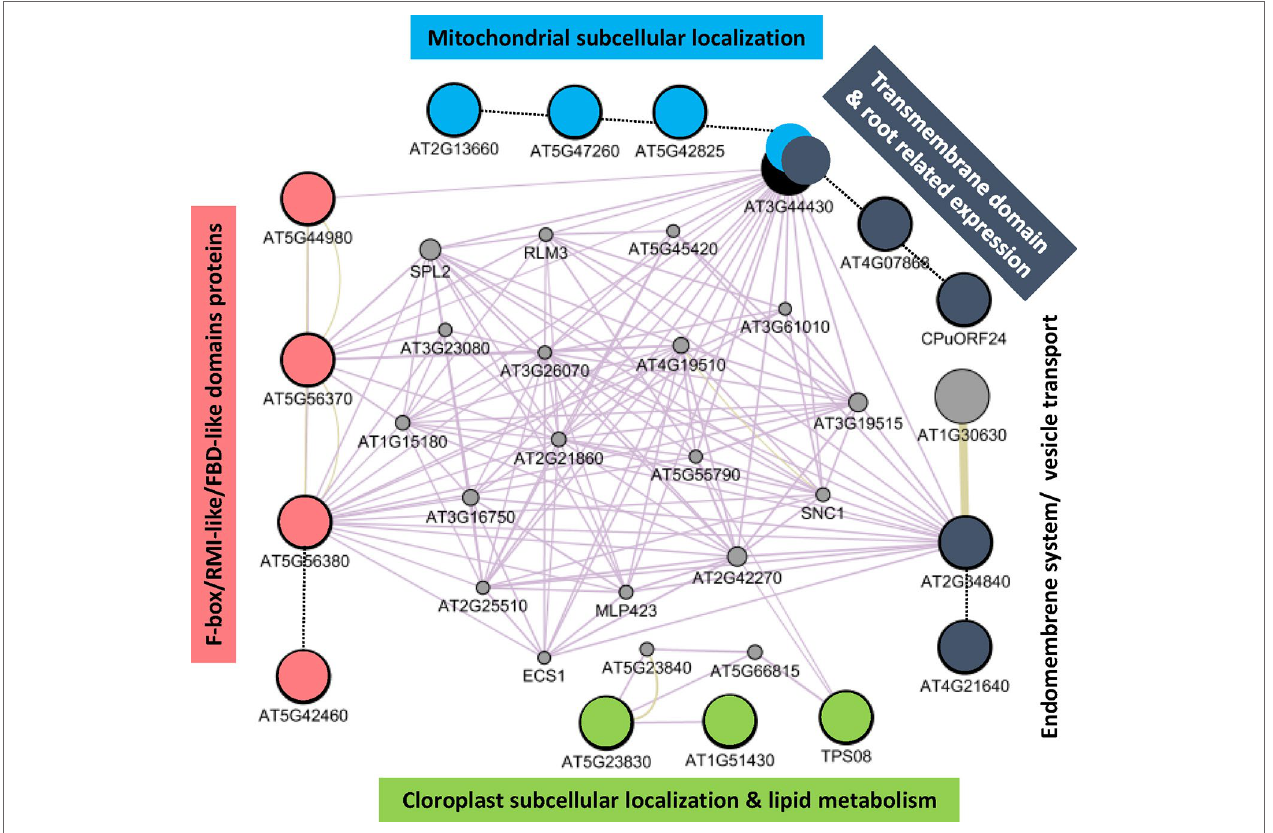
FIGURe 4 | Fifteen up-regulated genes in reduced gravity conditions can be connected in a gravity-response putative pathway. Large circles shown the genes detected in the first row clusters from the previous GEDI analysis ( Figure 3 ) and small circles are candidates to be members of a shared pathway (as detected by Genemania App in Cytoscape v3.6.1). While most of the genes have unknown function, color have been used to highlight shared features among their GO properties. Solid lines shown related features as detected by Genemania app, dotted lines have been added by manual datamining comparisons. Note that four genes expressing F-box/RMI-like proteins (in red) out of 156 genes (related examples are auxin polar transport genes as TIR-1, cell wall remodeling and even cyclins) in the genome may be key in the definition of a microgravity specific pathway characterized by the highly interconnected nodes in this graph.